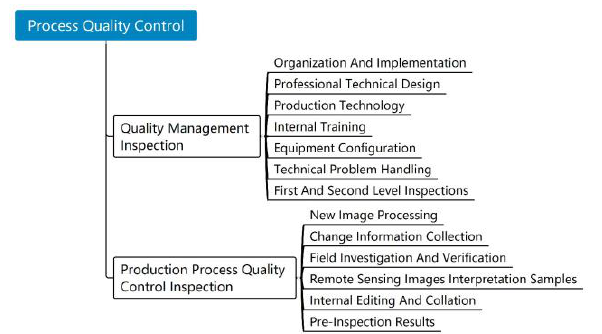
Figure 2 . Content of process quality